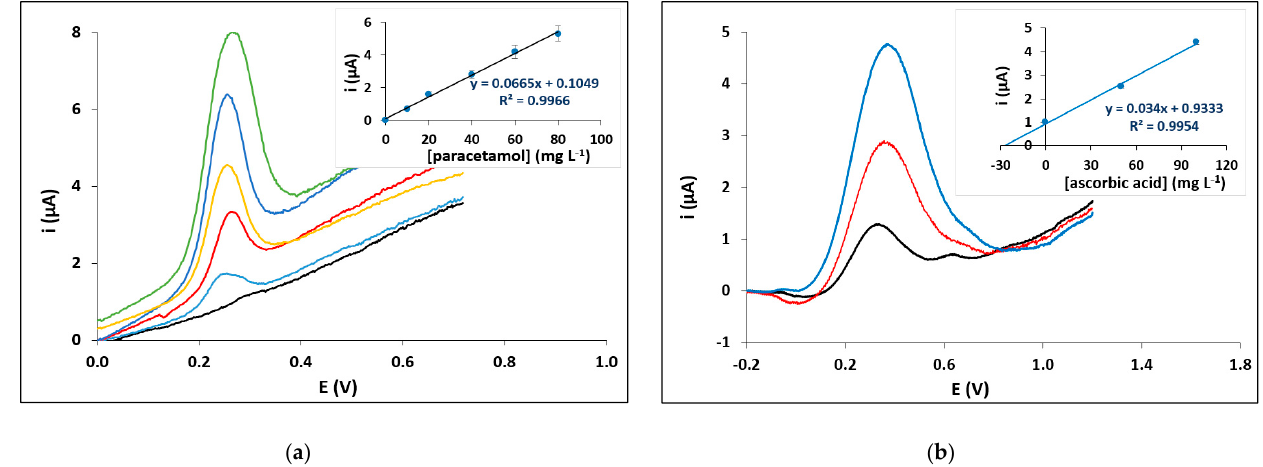
Figure 5. Application of the electrochemical PADs. ( a ) Voltammograms of different concentrations of paracetamol in a gin sample (calibration curve as inset). ( b ) Determination of ascorbic acid in an orange juice sample (standard additions curve as inset). Pen No 17; pencil 5B; paper 7; single-sided plotting; 2 passes; pen plotting speed 2.7 cm s − 1 ; pencil plotting speed 32 cm s − 1 ).